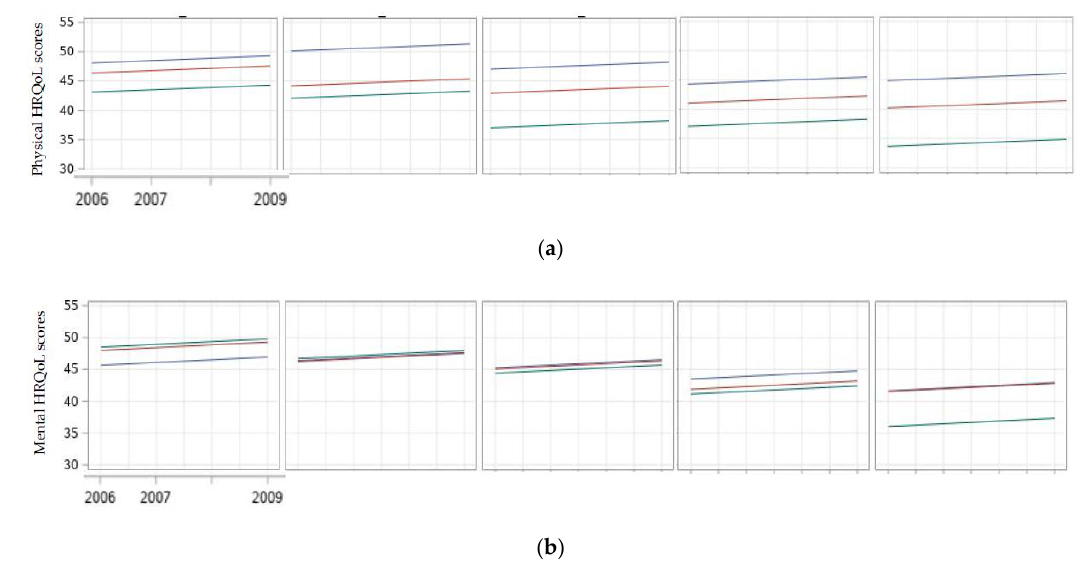
Figure 3. Trajectories of physical ( a ) and mental ( b ) HRQoL scores over time (2006–2009) in Positive Spaces, Healthy Places. Unmet basic needs (left to right) = met, 1-unmet, 2-unmet, 3-unmet, 4-unmet. Age groups: younger age (blue), middle-aged (red), older age